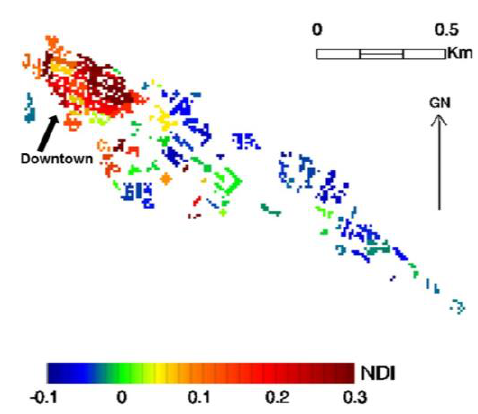
Figure 1: NDI map over Amatrice town obtained from pre- and post-seismic Sentinel-2 image Actual NDI values range from -0.080 and 0.311, with the highest values centred on the historical centre of Amatrice town, where most severe damage were registered (Azzaro et al.